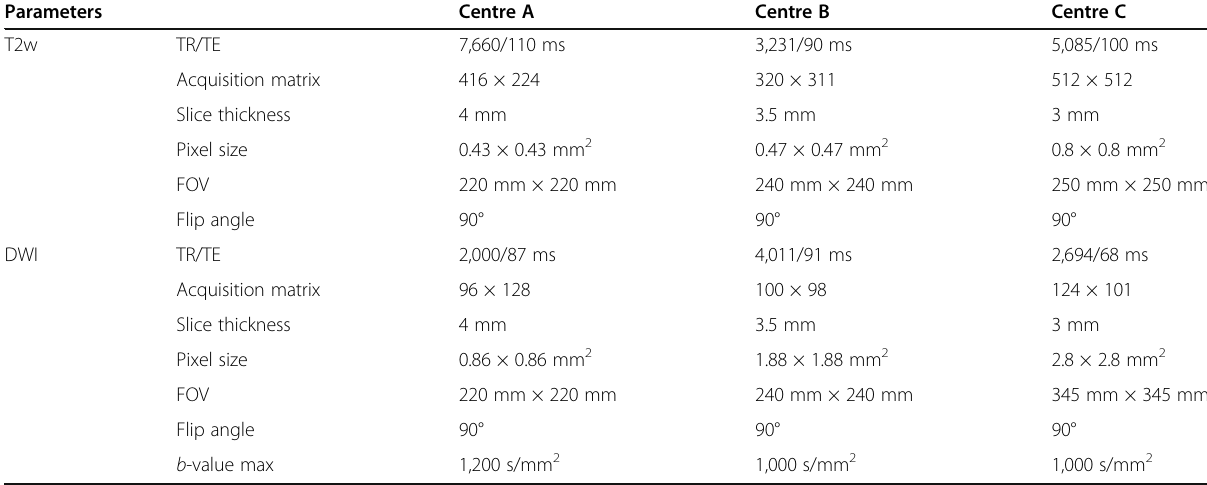
Table 1 Multiparametric MRI acquisition